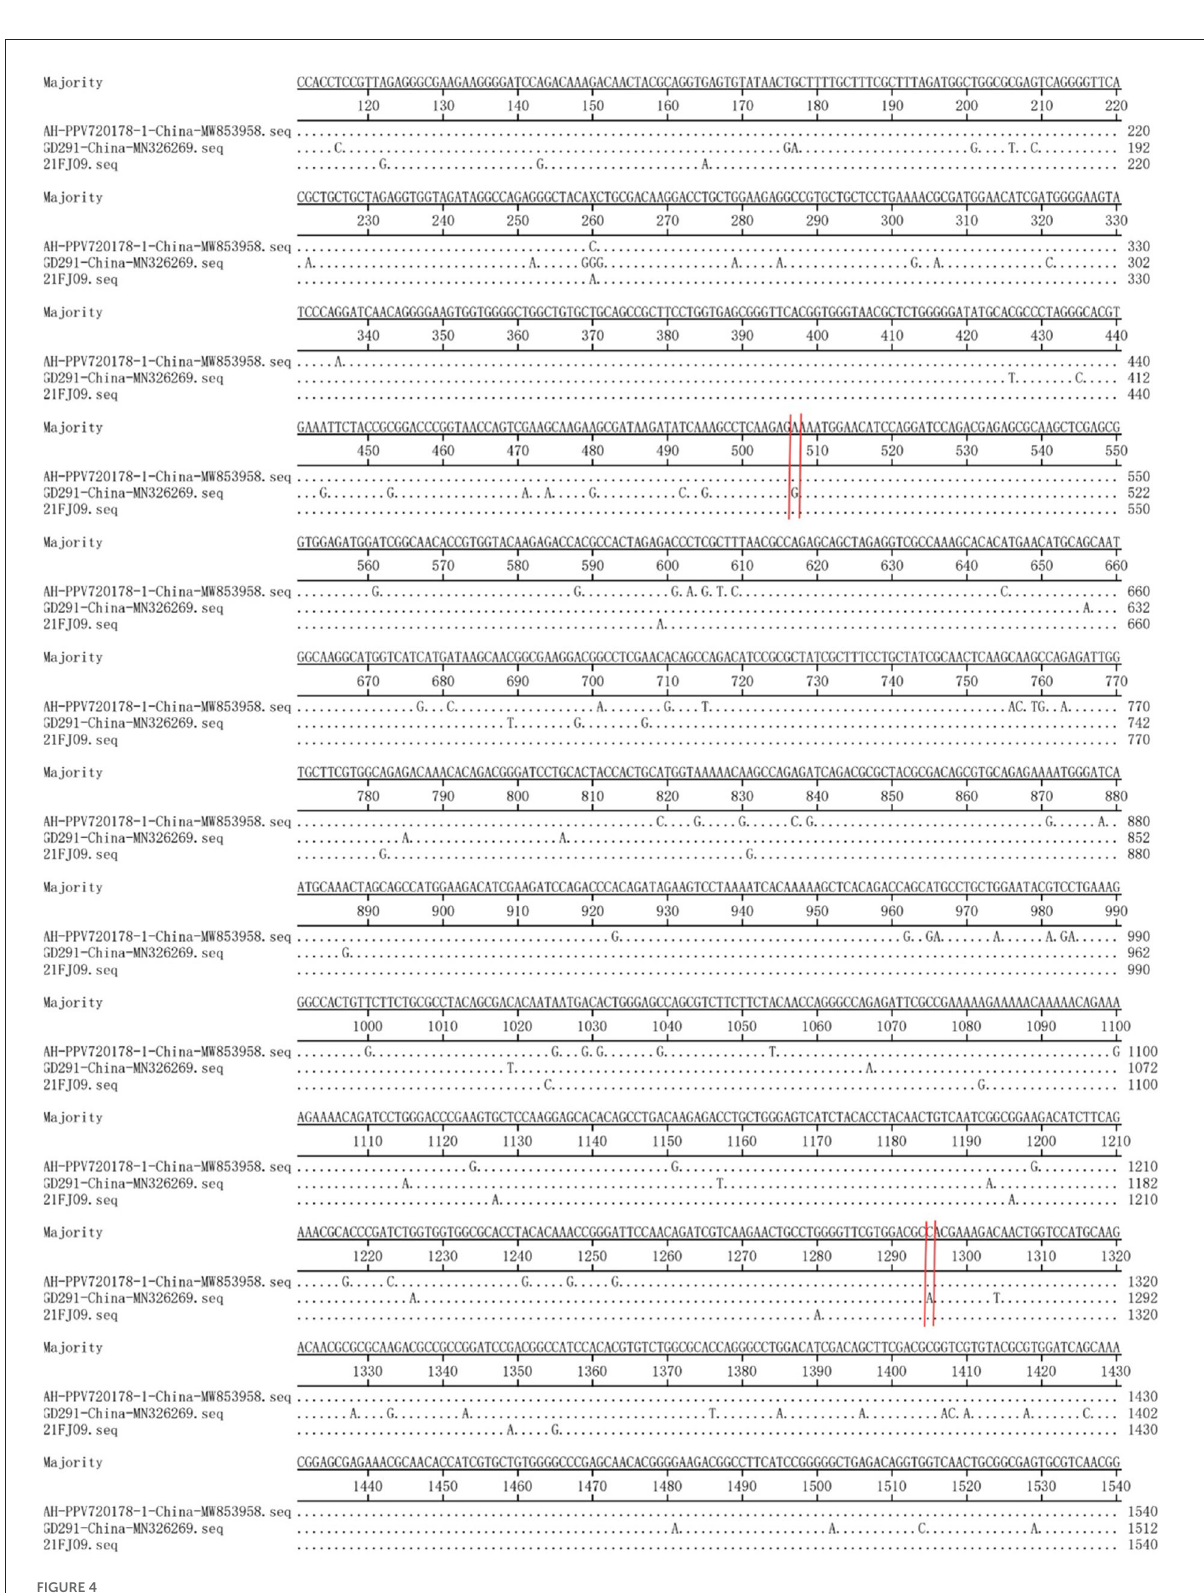
FIGURE4 Base-by-base comparison of the recombination fragment of the 21FJ09 isolate and probable parents (GD291 and AH-PPV720178-1). The position of the potential breakpoint is bracketed by two vertical lines.